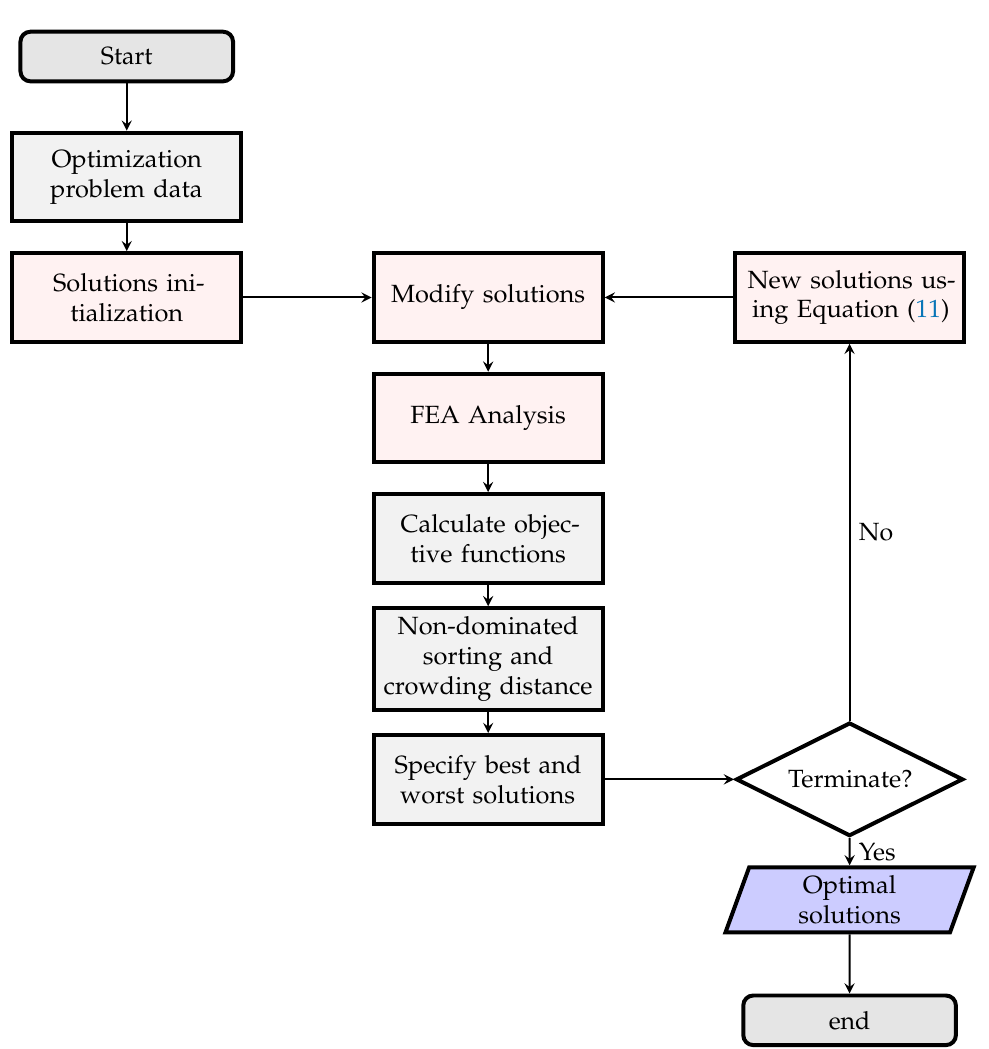
Figure 3. Flowchart of MO-Jaya